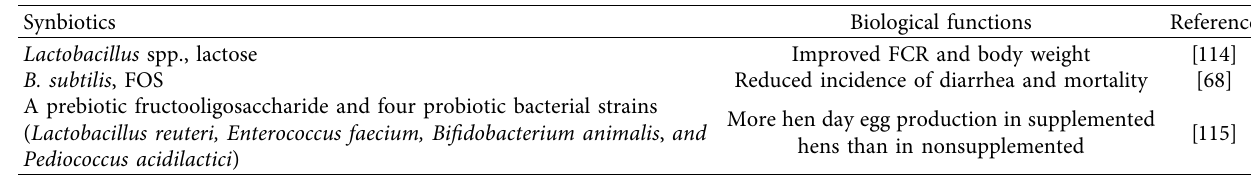
Table 3: Synbiotics and their biological